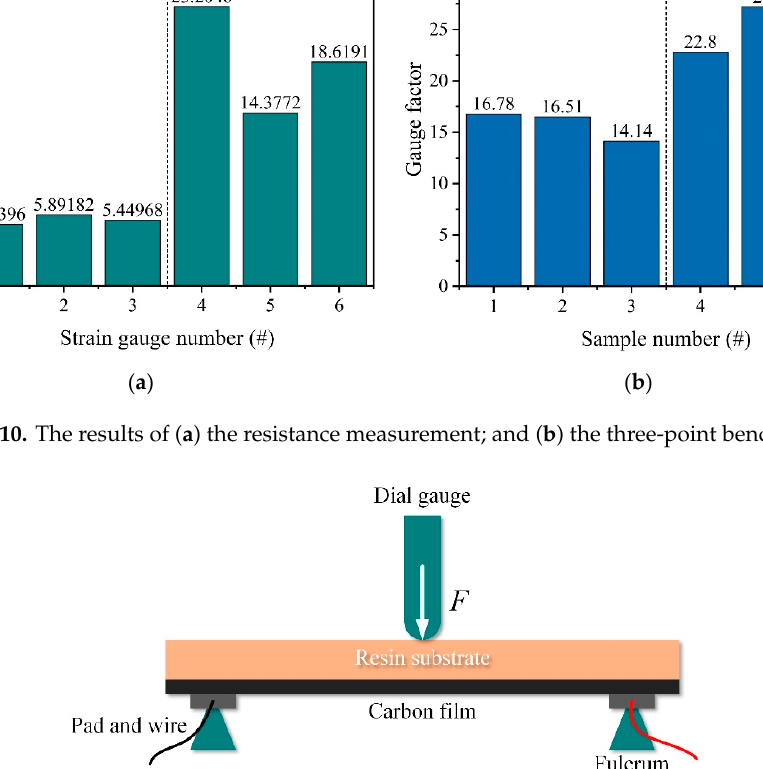
Figure 11. The schematic diagram of the three-point bending test. Table 3. Data for the gauge factor of the carbon paste-based samples.